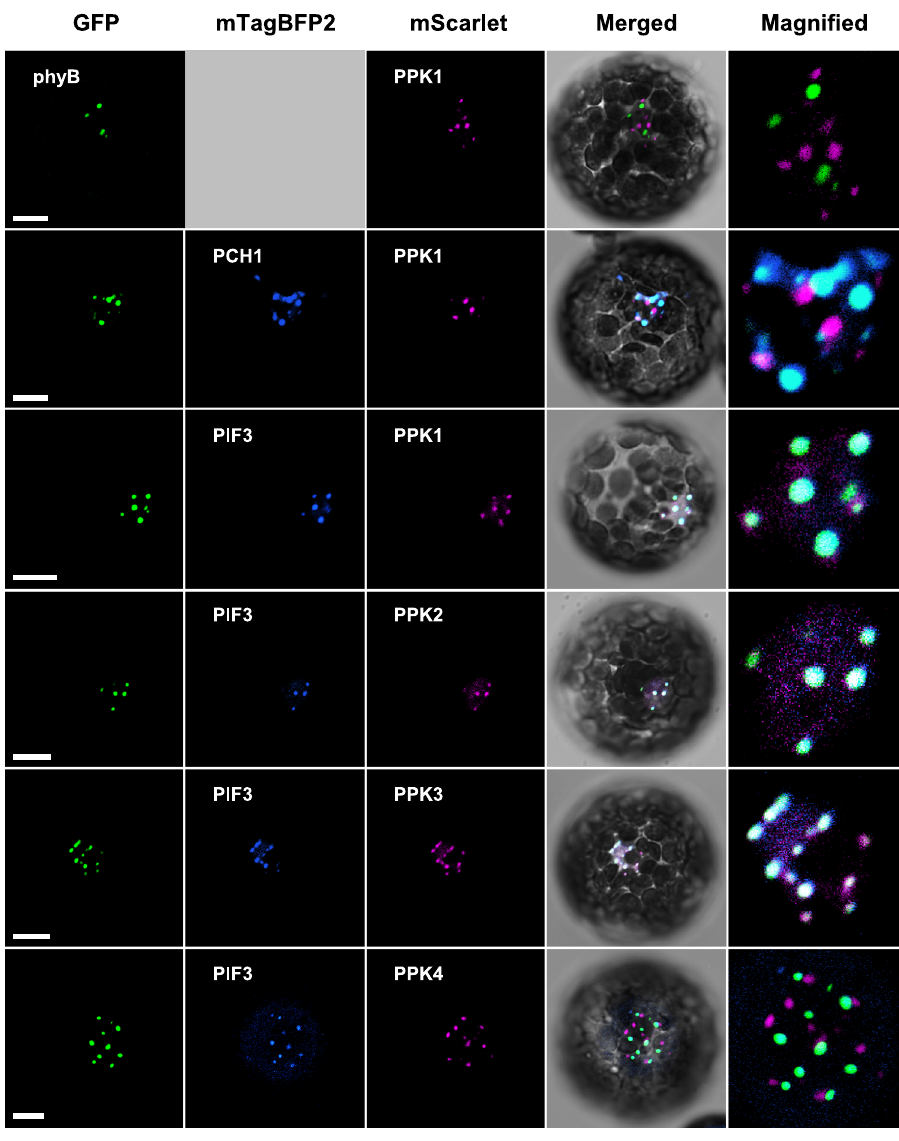
(Magni fi ed). An empty square indicates no co-transformation of any mTagBFP2- fused protein. The transformed protoplasts were cultured for 16h under con- tinuous white light (10 μ mol/m 2 /s). Scale bars=10 μ m. The representative images were shown in observation of at least 30 independent protoplasts. The observed fractions of the protoplasts showing co-localization are listed in Supplementary Data 2. The quantitative fl uorescent intensity pro fi les of the co-localization are in Supplementary Fig. 10. Source data are provided as a Source Data fi